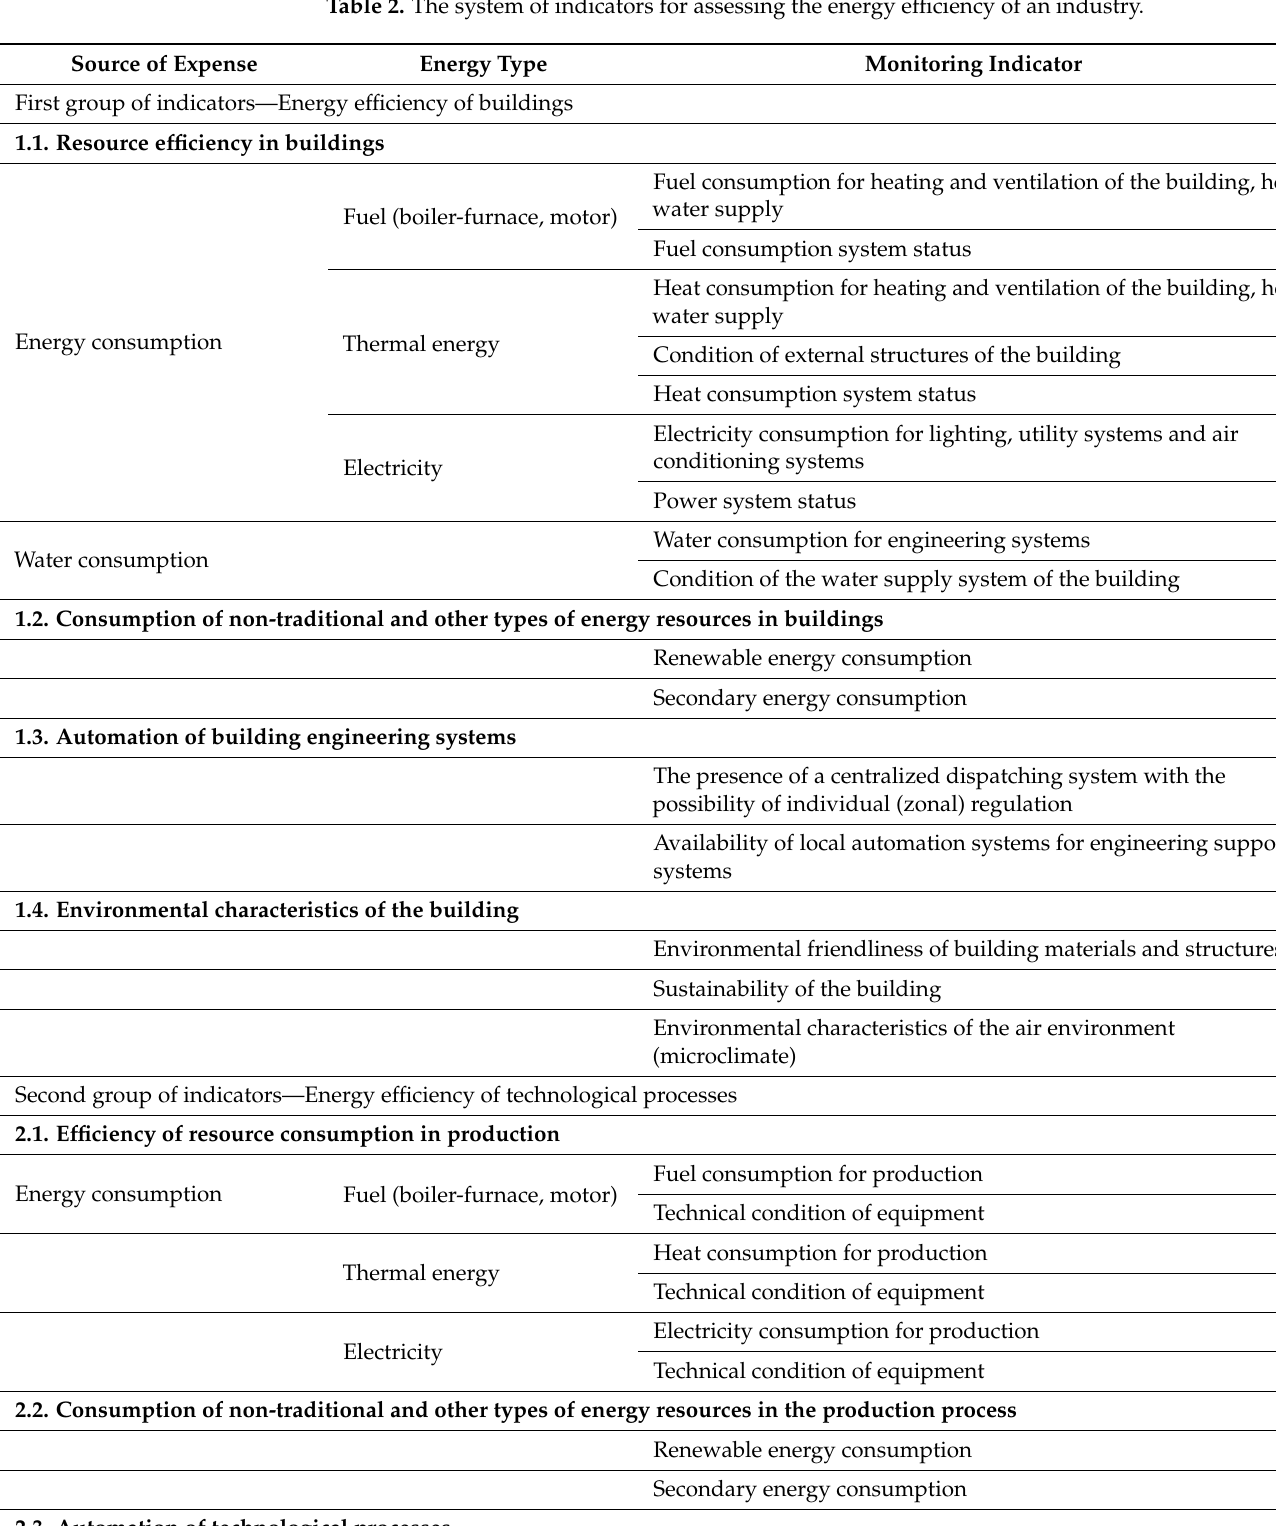
Table 2. The system of indicators for assessing the energy efficiency of an